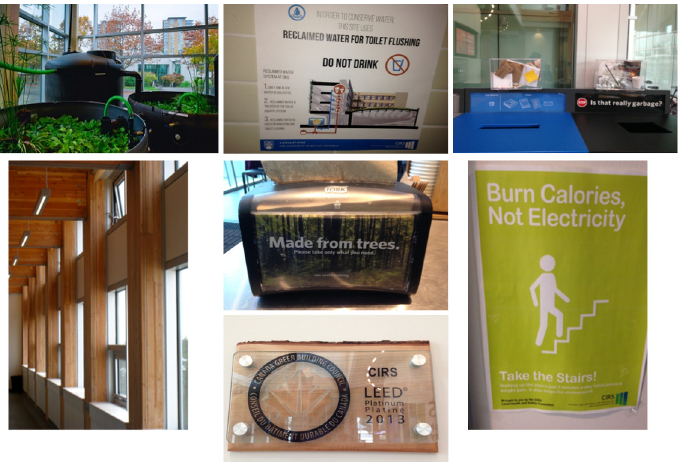
Fig 3. Examples of how the CIRS building conveys an atmosphere of sustainability to users. From top left to bottom right: water collection and purification system, signage in washroom about the water collection and purification system, 3D signage at waste receptacles in the café, extensive use of wood in the building ’ s construction, messaging on paper napkin holders in the café, LEED platinum certification display in the lobby, signage by the elevators to increase the use of